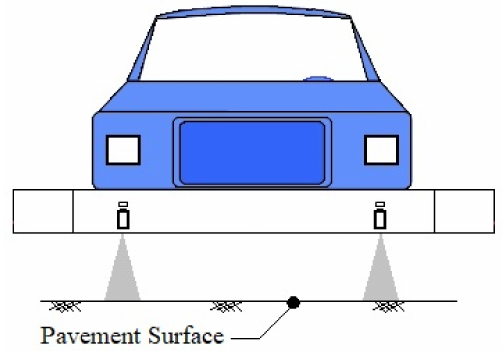
Figure 3. The line laser system for determining IRI in wheels